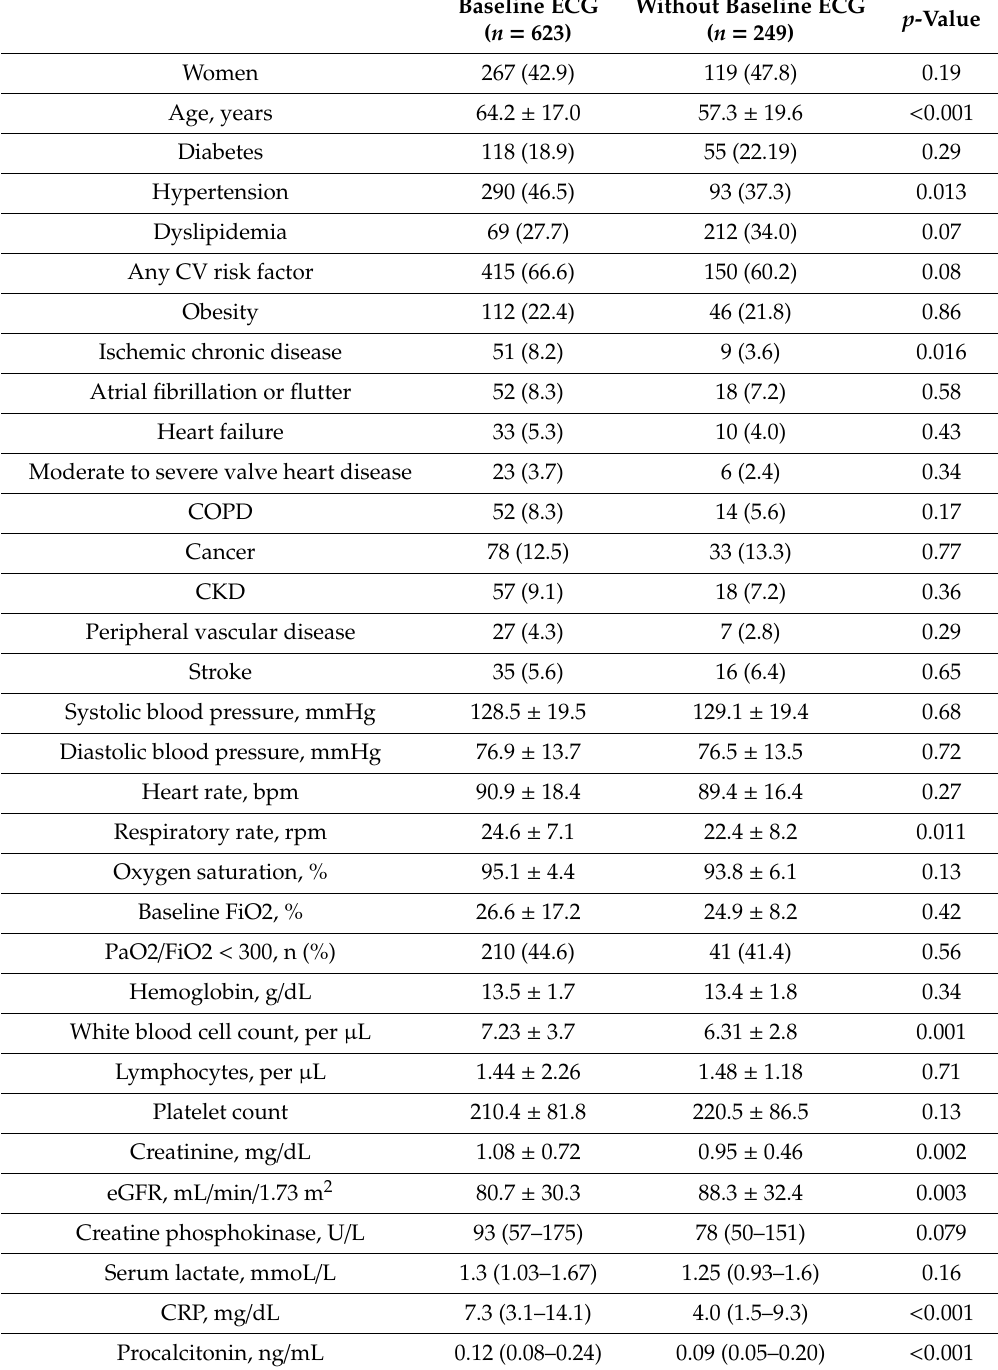
Table 7. Comparison of baseline characteristics, clinical presentation, treatment, and outcome between patients with and without ECG on